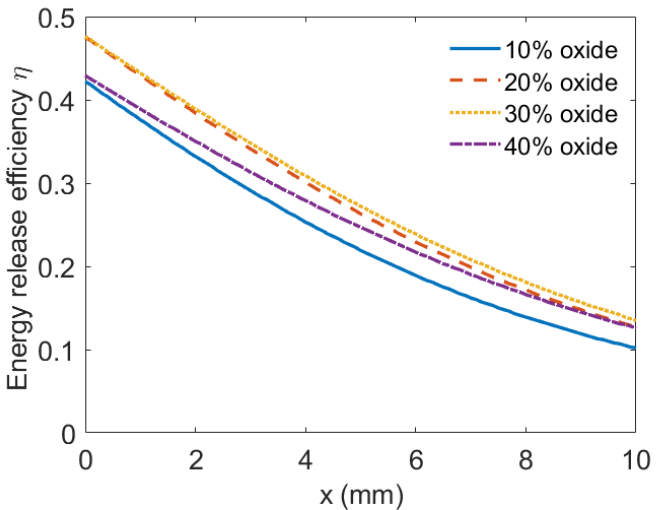
Figure 9. Energy release efficiency at each position of energetic materials.